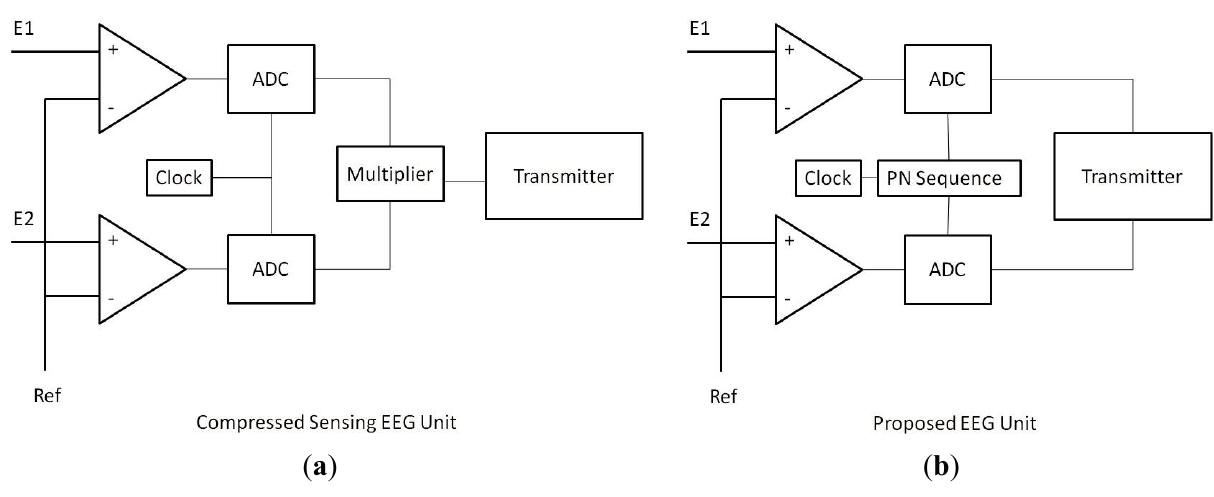
Figure 1. Compressed Sensing vs . Proposed EEG Acquisition and